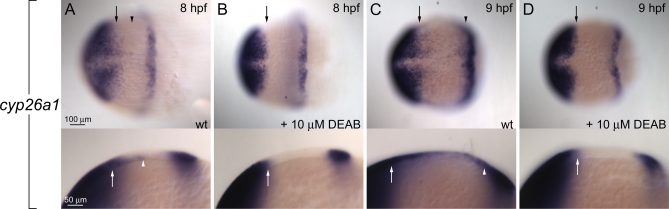
RA-Dependent Expression of cyp26a1
Wild-type (wt) and DEAB-treated embryos were stained for extended periods of time for cyp26a1 expression to investigate low-level expression. Top, dorsal view; bottom, lateral view.(A and C) Weak expression posterior to the presumptive midbrain (arrow to arrowhead).(B and D) This expression is lost in DEAB-treated embryos.